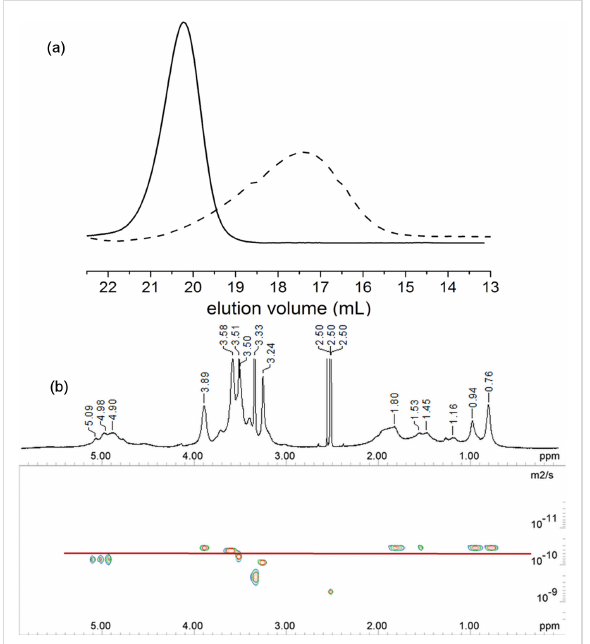
Figure 2: (a) GPC traces of the macroCTA 5 (solid line) and the poly(TRIS-AAm)- b -polyisoprene- b -poly(TRIS-AAm) polyrotaxane 6 (dashed line), and (b) 500 MHz, 1 H NMR and DOSY spectra of poly- HEMA- b -polyisoprene- b -polyHEMA polyrotaxane 4 in DMSO- d 6